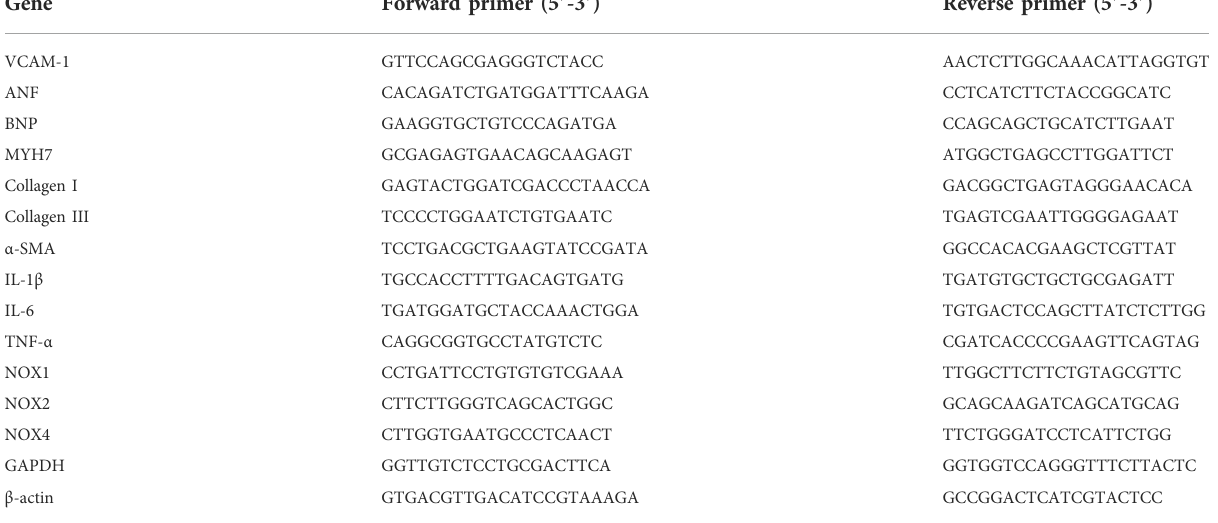
TABLE 1 Primers used for quantitative real-time PCR